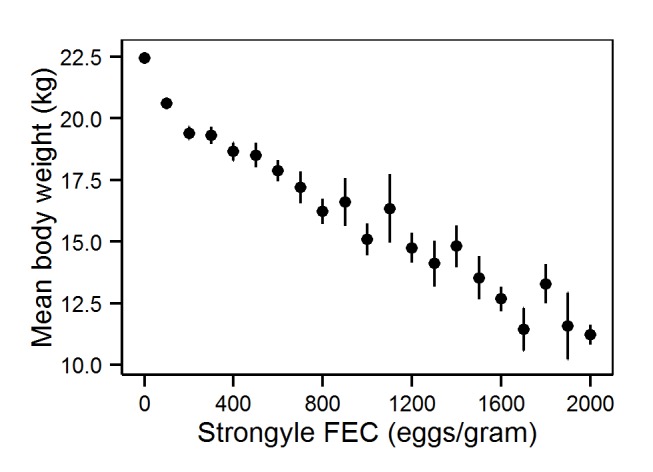
Mean, population-level tolerance of Soay sheep to gastrointestinal nematodes.The negative association between body weight and strongyle FEC was estimated from data on 4,934 captures of 2,438 individual sheep. Points show mean body weight for each level of FEC (2,000 =  counts of 2,000 eggs/gram or over) ±1 SE. Plot data are shown in Table S4.